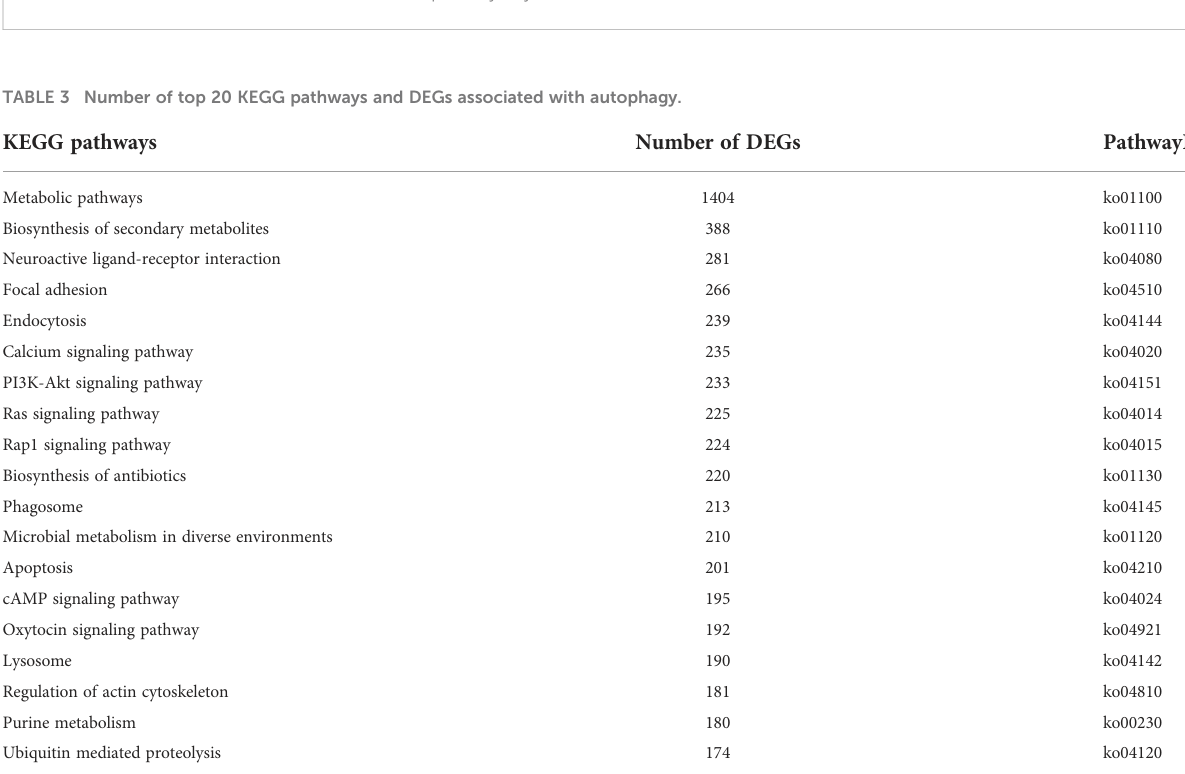
FIGURE 4 KEGG classi fi cations of DEGs. The most abundant pathway is lysosome.